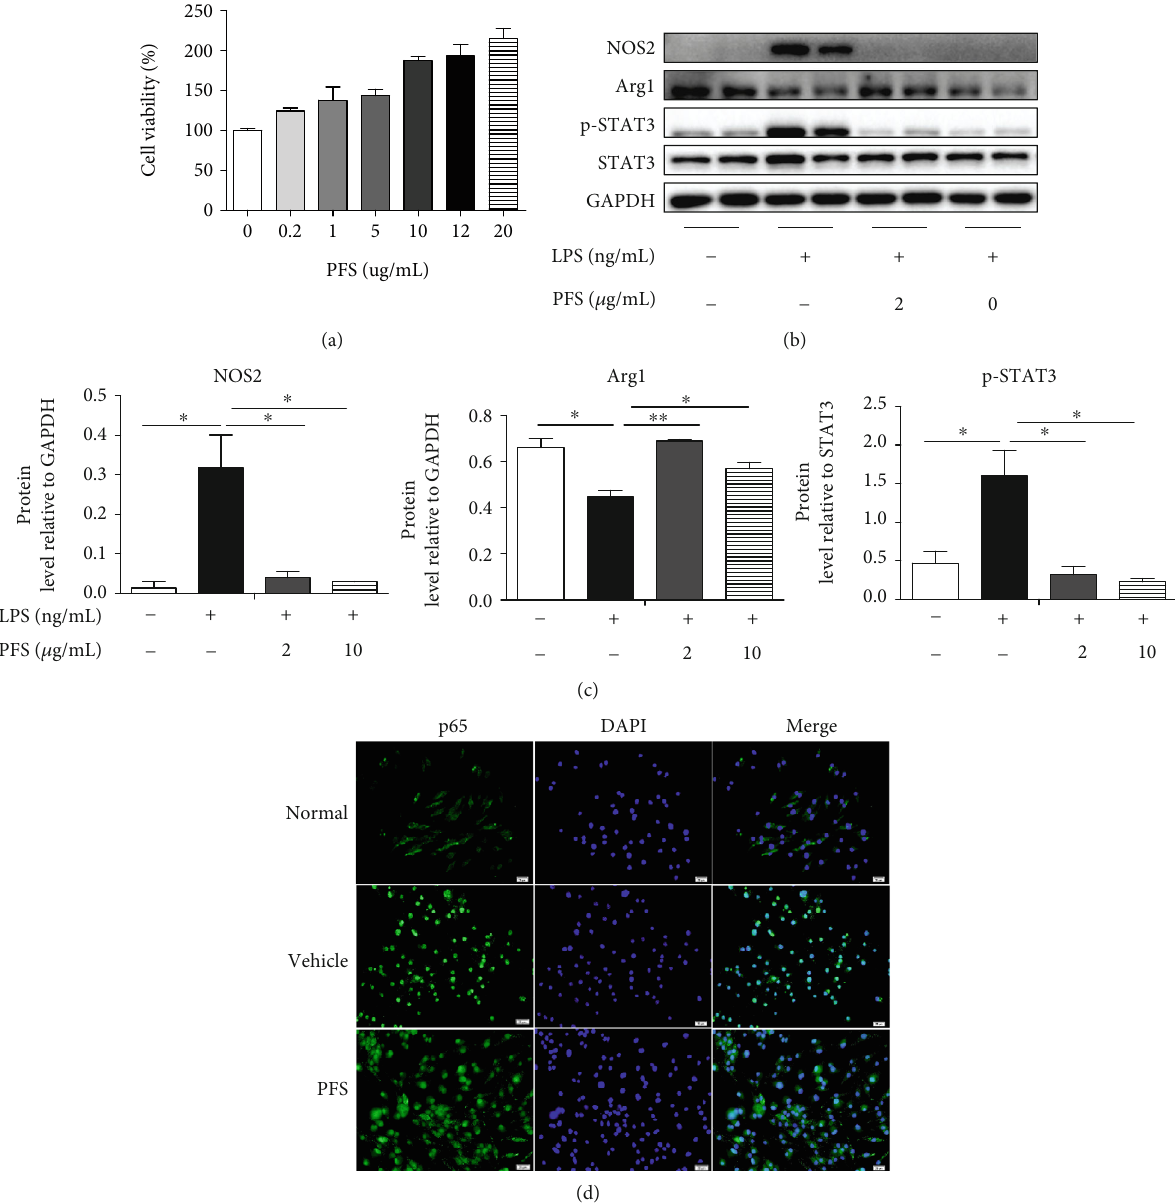
Figure 7: Immunomodulatory e ff ects of PFS on LPS-induced M1 macrophage polarization. (a) BMDMs in 96-well plates ( 5 × 10 4 cells/well) were cultured in the presence or absence of di ff erent concentrations of PFS for 24 h; then, 100 μ L of 5 mg/mL MTT was added and incubated for 4 h, the formazan formed in the intact cells was dissolved with 150 μ L/well dimethyl sulfoxide (DMSO) at 37 ° C for 10min, the OD was measured at 490nm, and cell viability was calculated ( n = 6 ). (b) SDS-PAGE protein bands and (c) the optical densities; BMDMs in 6-well plates ( 1 × 10 6 cells/well) were pretreated with PFS at 2 μ g/mL and 10 μ g/mL for 12h and stimulated with LPS (500ng/mL) for 0.5 h; then, protein samples were collected. The expression of macrophage-associated factors was detected using western blot ( n = 3 ). The results were means ± SD , ∗ p < 0 : 05 and ∗∗ p < 0 : 01 versus the vehicle group. (d) Macrophage polarization and nuclear localization of p65 were performed by immuno fl uorescence staining. Scale bar, 20 μ